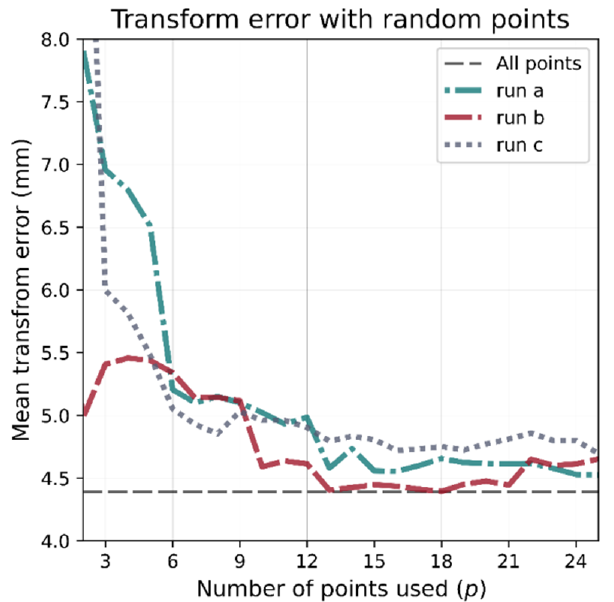
Figure 7. Dependence of transform accuracy on the number of calibration points. As more points are used, accuracy improves. The dashed grey line represents the ideal transform calculated using all 625 points. Using randomly chosen calibration points produces inconsistent results.